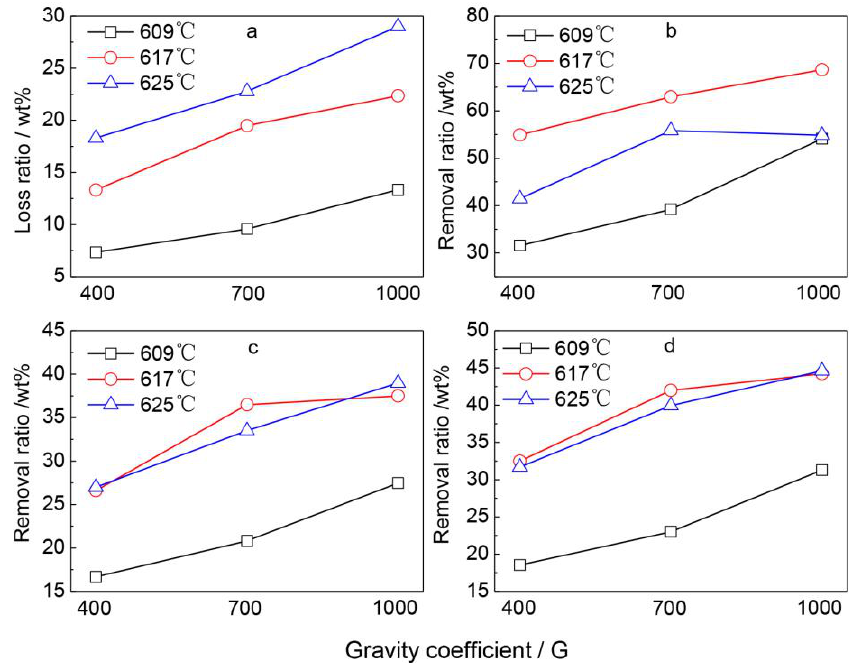
Figure 8. Loss ratio of Al phase ( a ) and removal ratio of tramp elements (( b ): Cu, ( c ): Mg, ( d ): Zn).